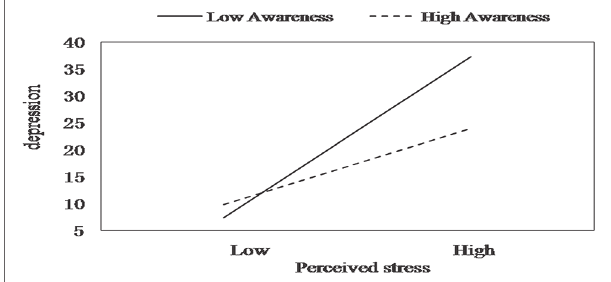
FIGURE 2 | The moderating effect of acting with awareness on the relation between stress and